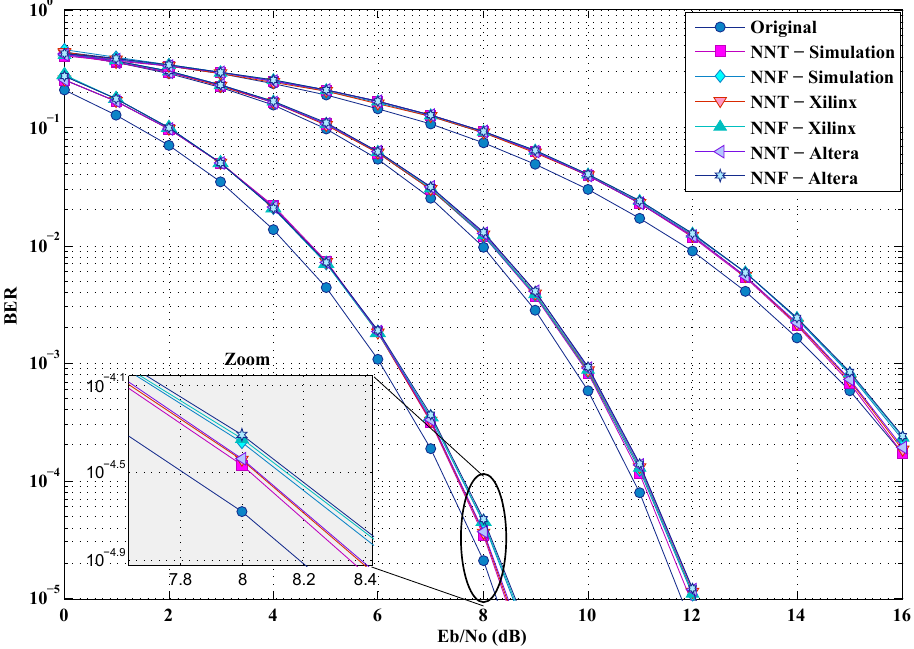
Figure 18. BER of the implementations for a CM1